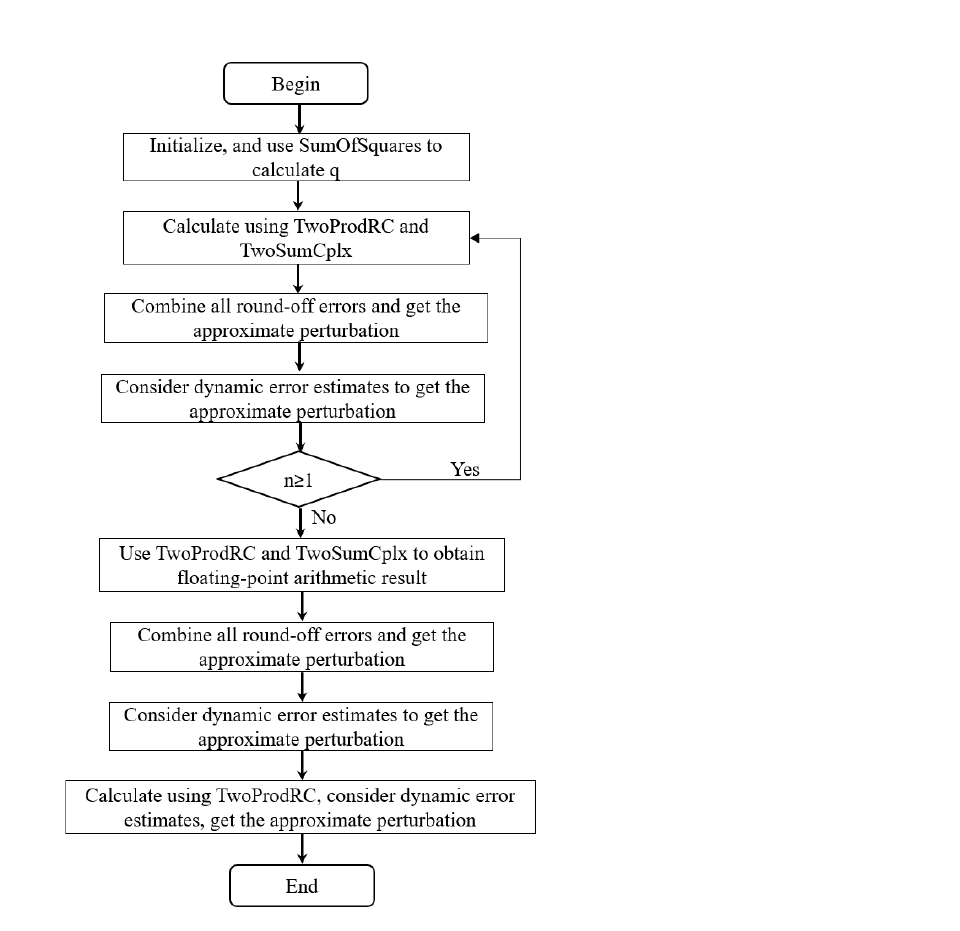
Figure 2. The flowchart of the compensated Goertzel algorithm with dynamic error estimates. Algorithm 7 Polynomial evaluation by the compensated Horner algorithm